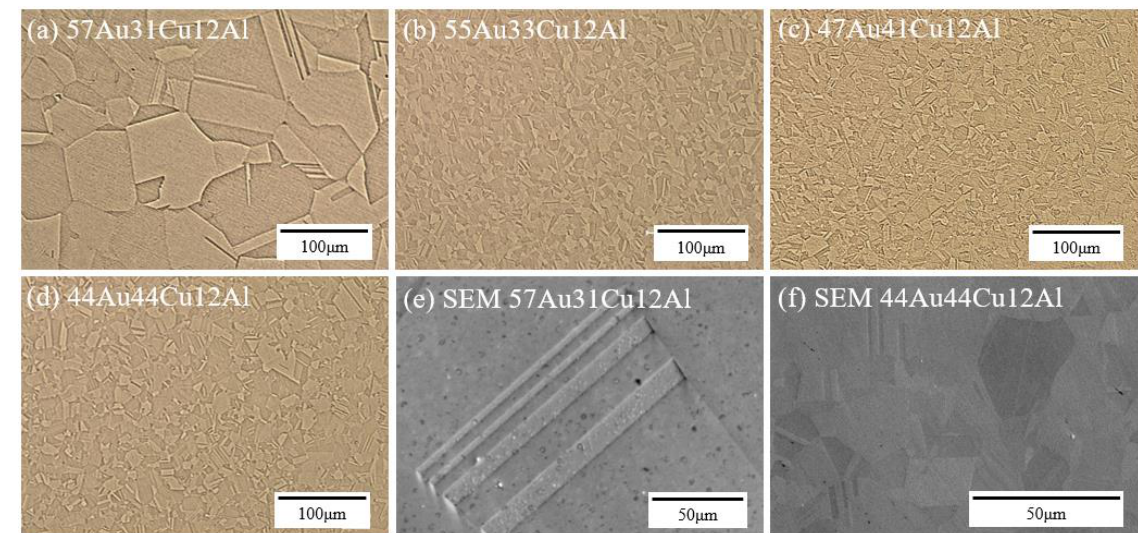
Figure 1. OM images of ( a ) 57Au31Cu12Al, ( b ) 55Au33Cu12Al, ( c ) 47Au41Cu12Al, and ( d ) 44Au44Cu12Al alloys as well as SEM images of ( e ) 57Au31Cu12Al and the ( f ) 44Au44Cu12Al alloys.